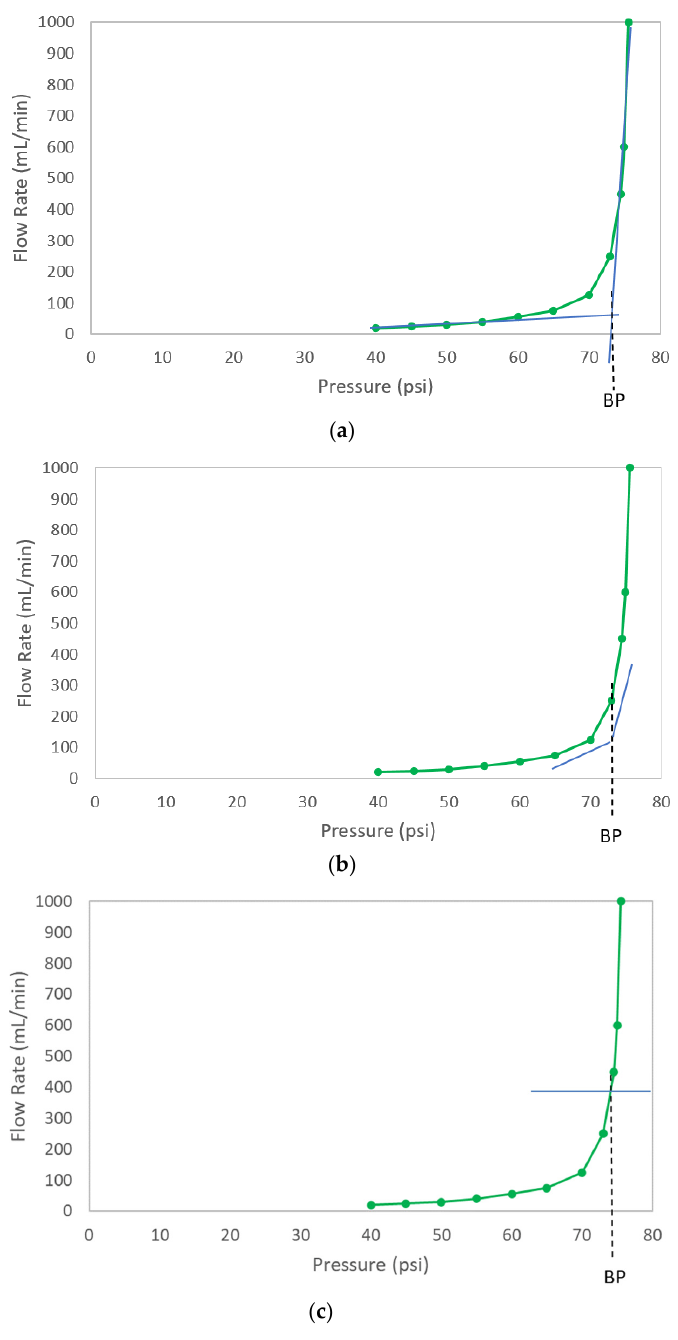
Figure 5. Determination of bubble point from flow rate vs. pressure spectra: ( a ) tangent method; ( b ) slope change threshold method; ( c ) threshold flow rate method.